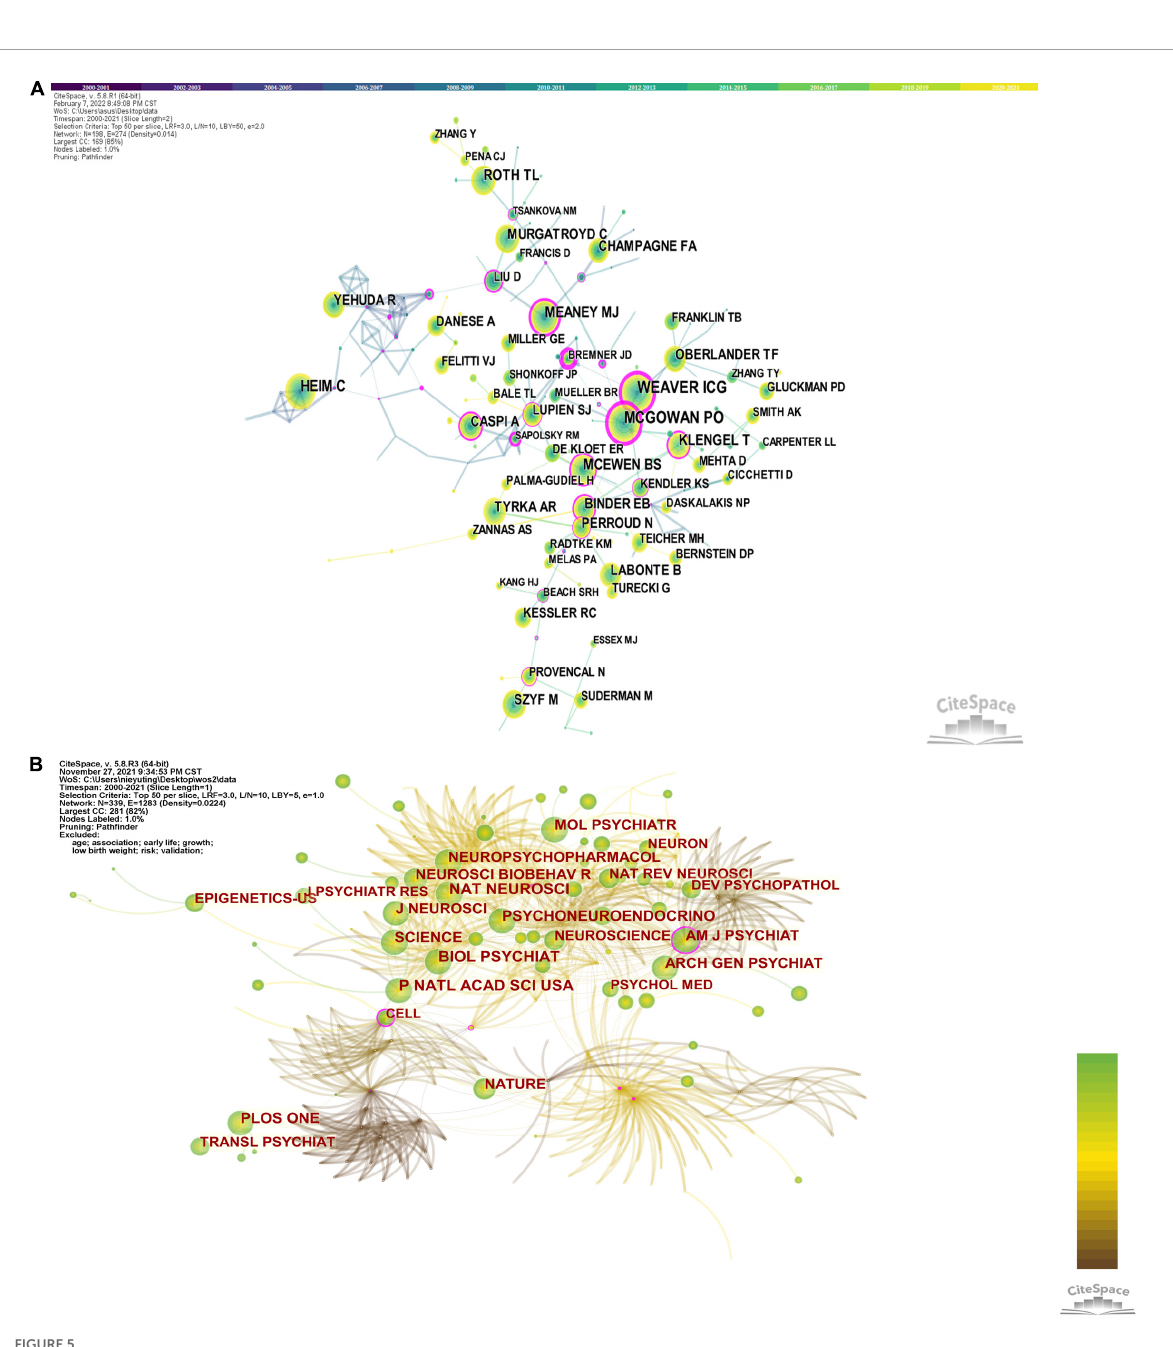
network can reveal the literature that plays a key role in the evolution of the research frontier in the field. The clustering of the reference co-citation network by the LLR algorithm has been divided into 17 clusters ( Q = 0.6698, S = 0.8472), which are shown in Figure 6A . The largest seven groups of references in the co-citation network were selected, and the details are shown in Table 4 . The visual timeline contains 1,039 nodes and 4,927 links, representing cited references